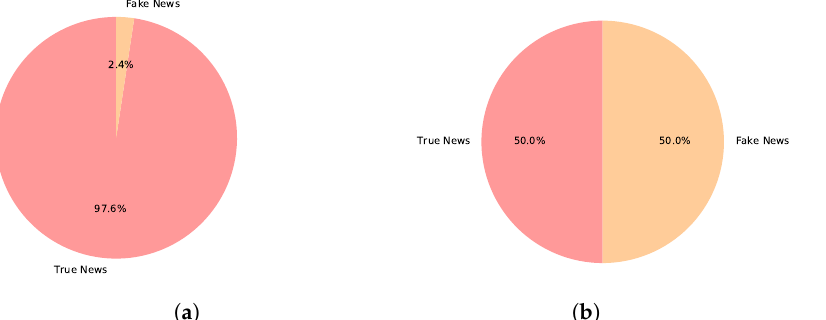
Figure 2. The amount of fake and true news in both the balanced (augmented) and imbalanced (original) datasets. ( a ) Imbalanced dataset; ( b ) Balanced